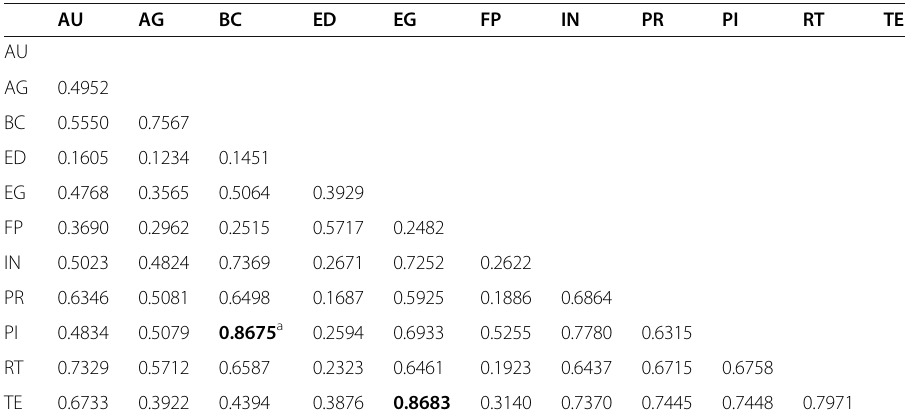
Table 6 Discriminant validity — HTMT ratio